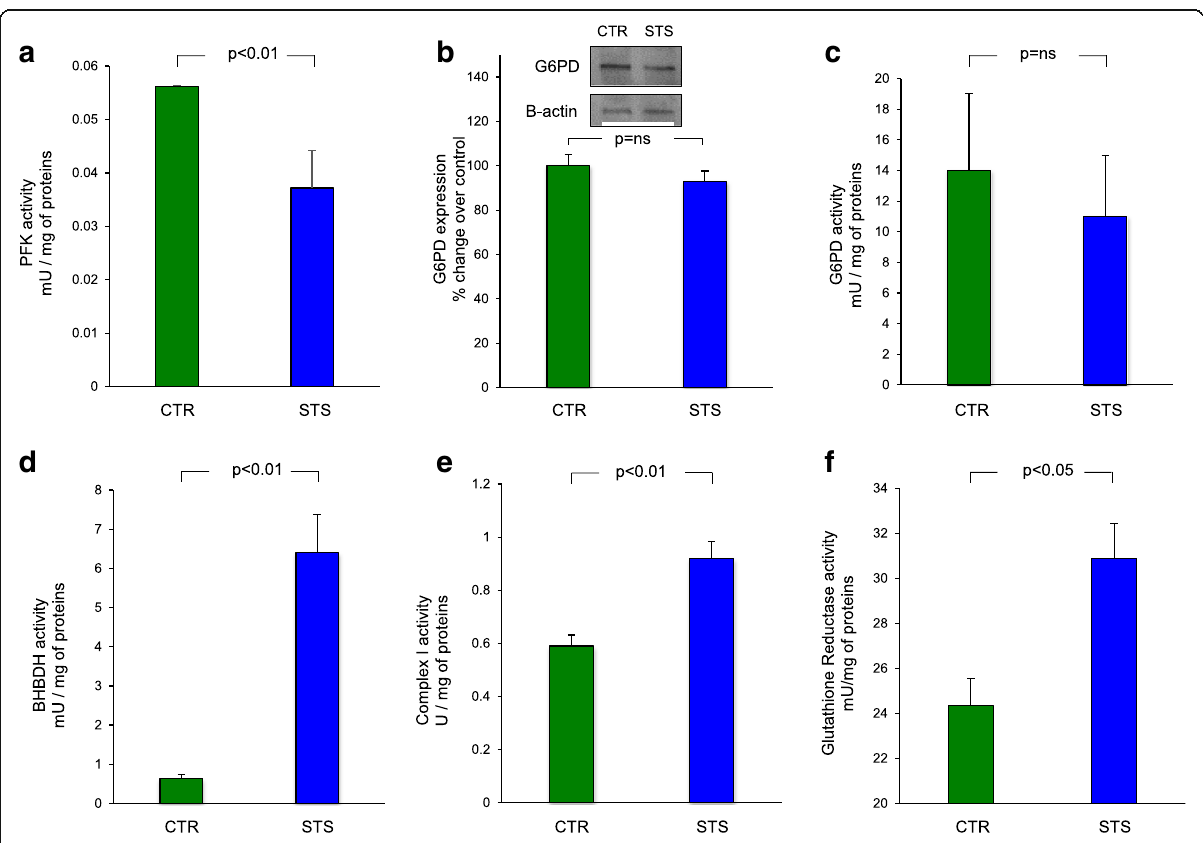
Fig. 5 Metabolic machinery of starved brain. In each panel, green bars represent the brain homogenate of control (CTR) mice and the blue bars represent the brain homogenate of starved (STS) mice. a The PFK activity expressed in mU × mg of proteins − 1 ± SD of at least three experiments. The catalytic activity was reduced in STS brain homogenate with respect to